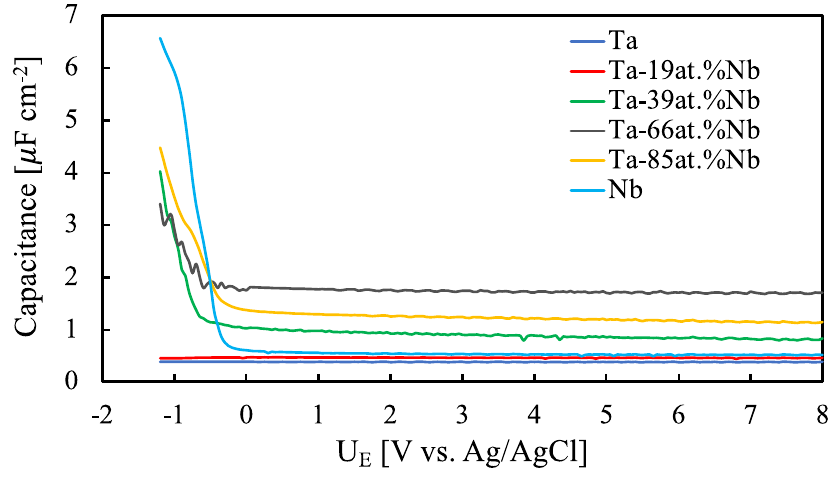
Figure 7. Measured series capacitance relating to all the investigated anodic oxides grown up to 50 V at 120 Hz in 0.25 M Na 2 HPO 4 solution (pH ~9).